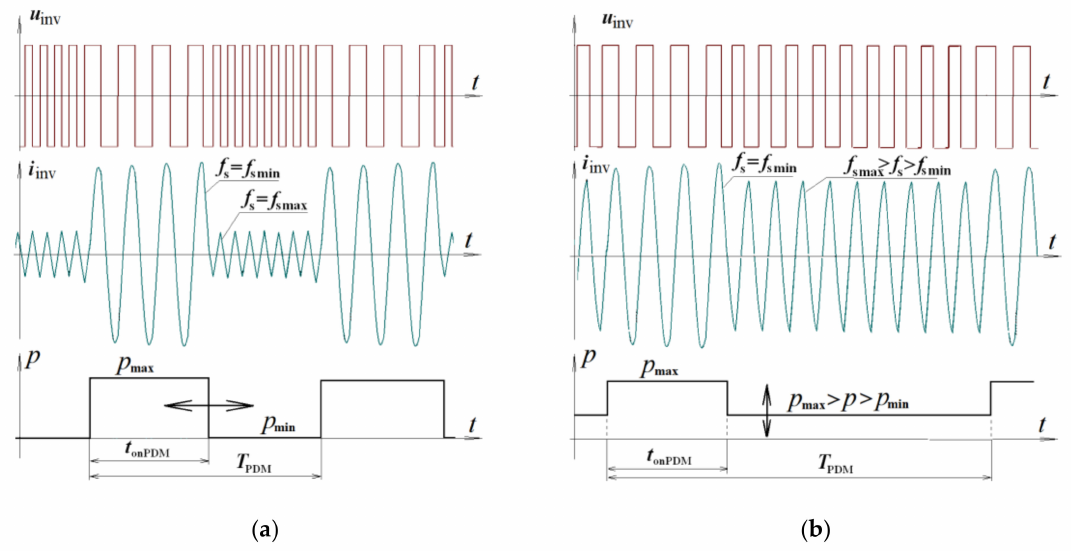
Figure 3. Examples of inverter output voltage and current waveforms using the PDM-PFM method developed by the authors: ( a ) with variable duty cycle of PDM signal, ( b ) at a constant duty cycle of PDM